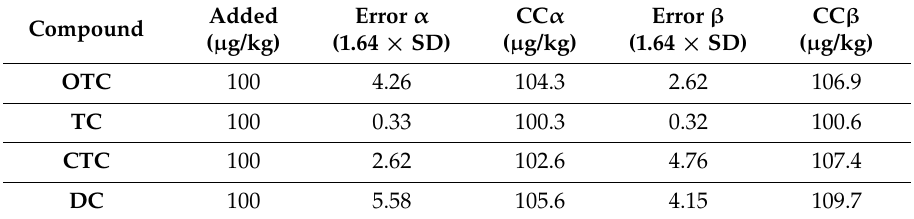
Table 5. Decision limit CC α and Detection capability CC β at the MRL